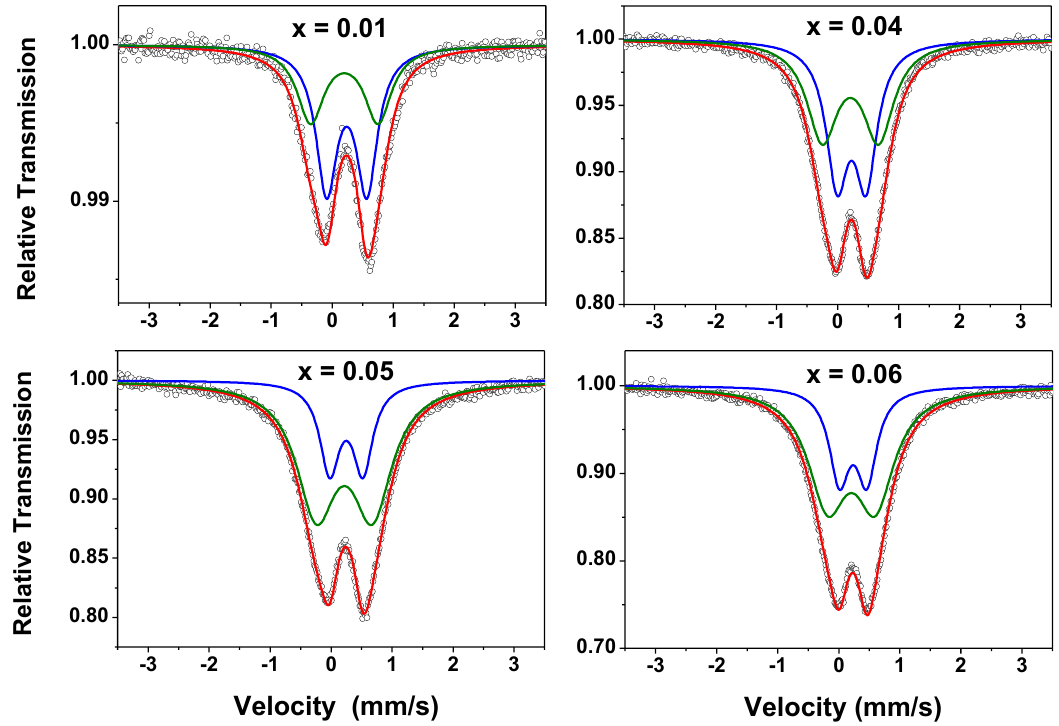
Figure 7. RT Mössbauer spectra taken with | Vmax | = 3.5 mm / s for the Zn 1-x Fe x O samples. The two subspectra (green and blue lines) used to fit the data are also shown in this figure.